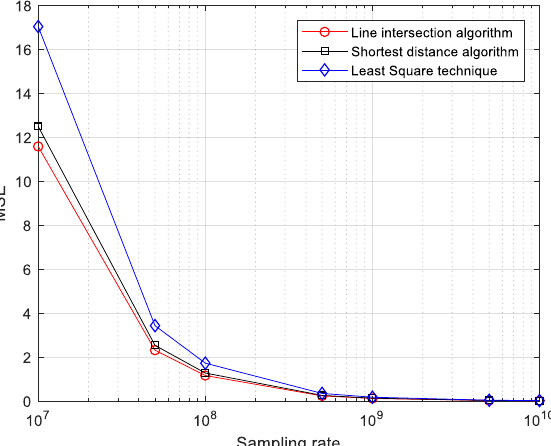
Figure 8. MSE of distances between MS and BSs for the third case.